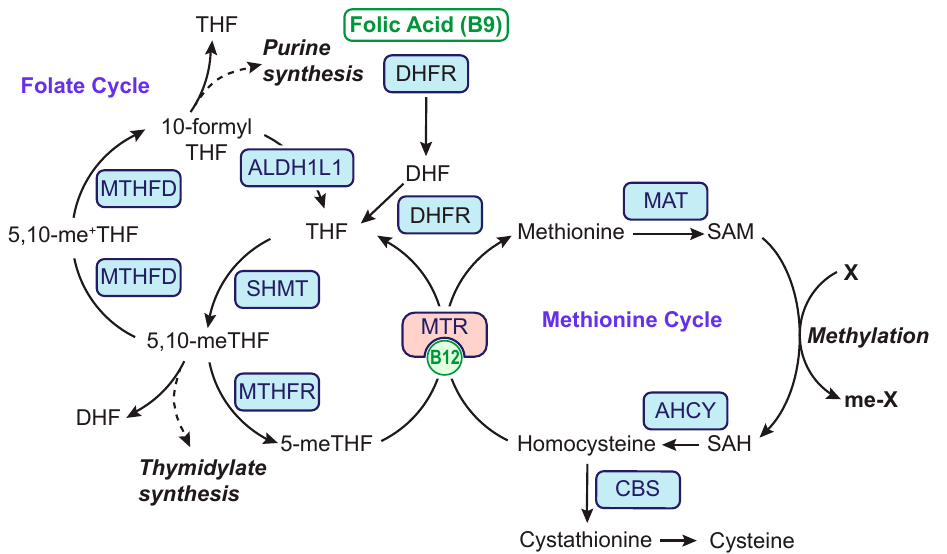
Figure 1. Schematic of one-carbon metabolism . The scheme includes the cytoplasmic folate and methionine cycles. B12 denotes vitamin B12. X denotes a methylation target. Abbreviations: MTHFD—